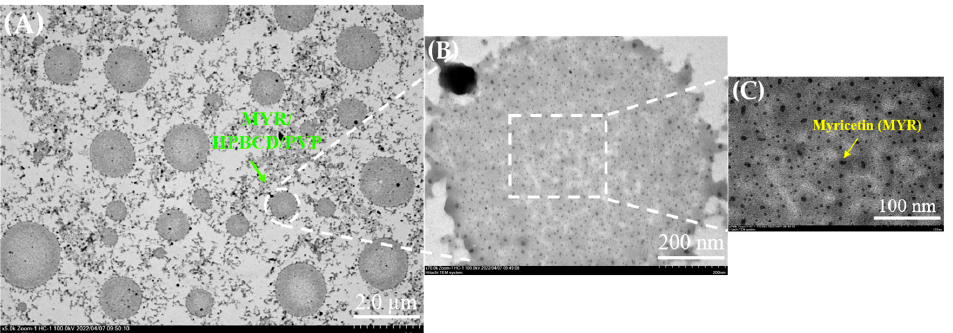
Figure 3. TEM images showing the inner morphology of myricetin nanofiber (MyNF 1:20:12) of ( A ) colloidal droplets of MYR/HPBCD/PVP, ( B ) PVP colloidal system containing dispersed MYR/HPBCD inclusion particles, and ( C ) a magnified view clearly revealing the conserved MYR/HPBCD size distribution.